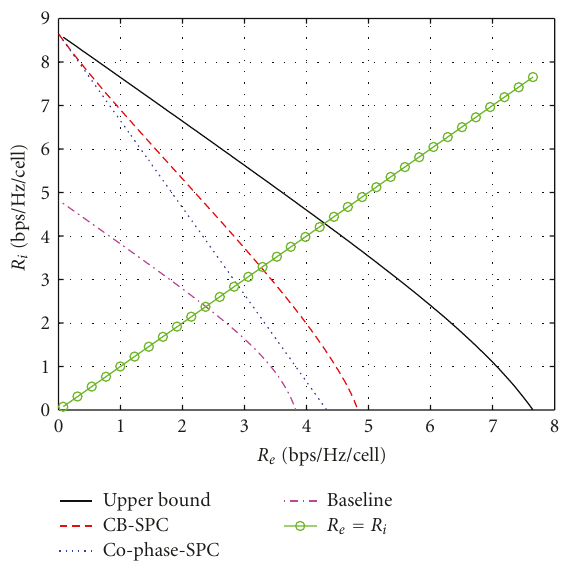
Figure 12: Double-class network, α = 1, β = 10, and SNR = 20dB.